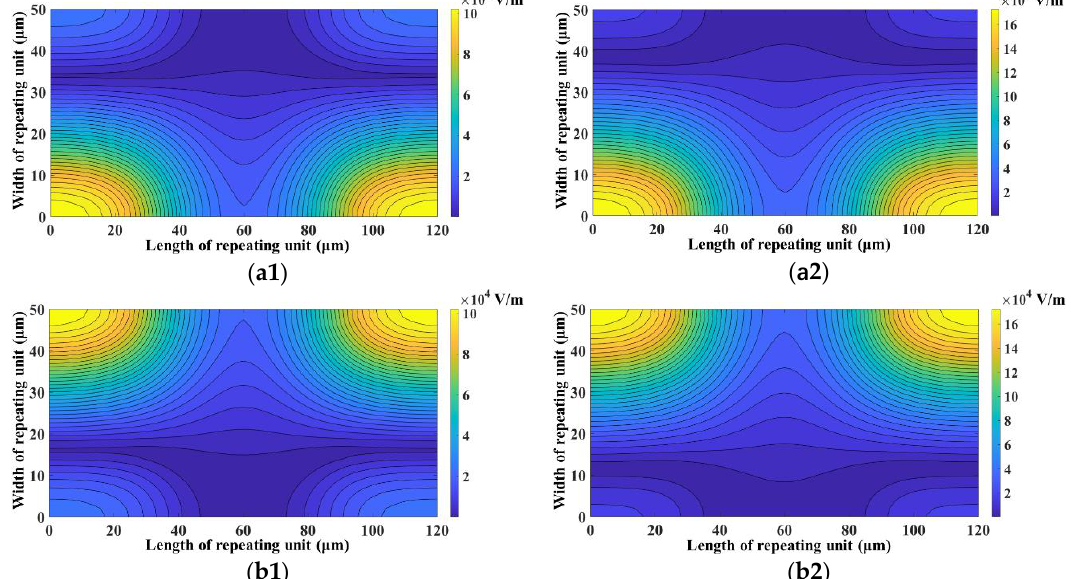
Figure 7. Electric field in the mid-plane along the height of ( a ) focusing section for ( a1 ) V 2 = 12 V pp and ( a2 ) V 2 = 20 V pp and ( b ) separation section for ( b1 ) V 3 = 12 V pp and ( b2 ) V 3 = 20 V pp ( d f = 60 μm, l f = 120 μm, d s = 60 μm, l s = 120 μm, w f = 6 μm, w s = 6 μm, V 1 = 4 V pp , V 4 = 4 V pp , H ch = 50 μm, W ch = 50 μm).